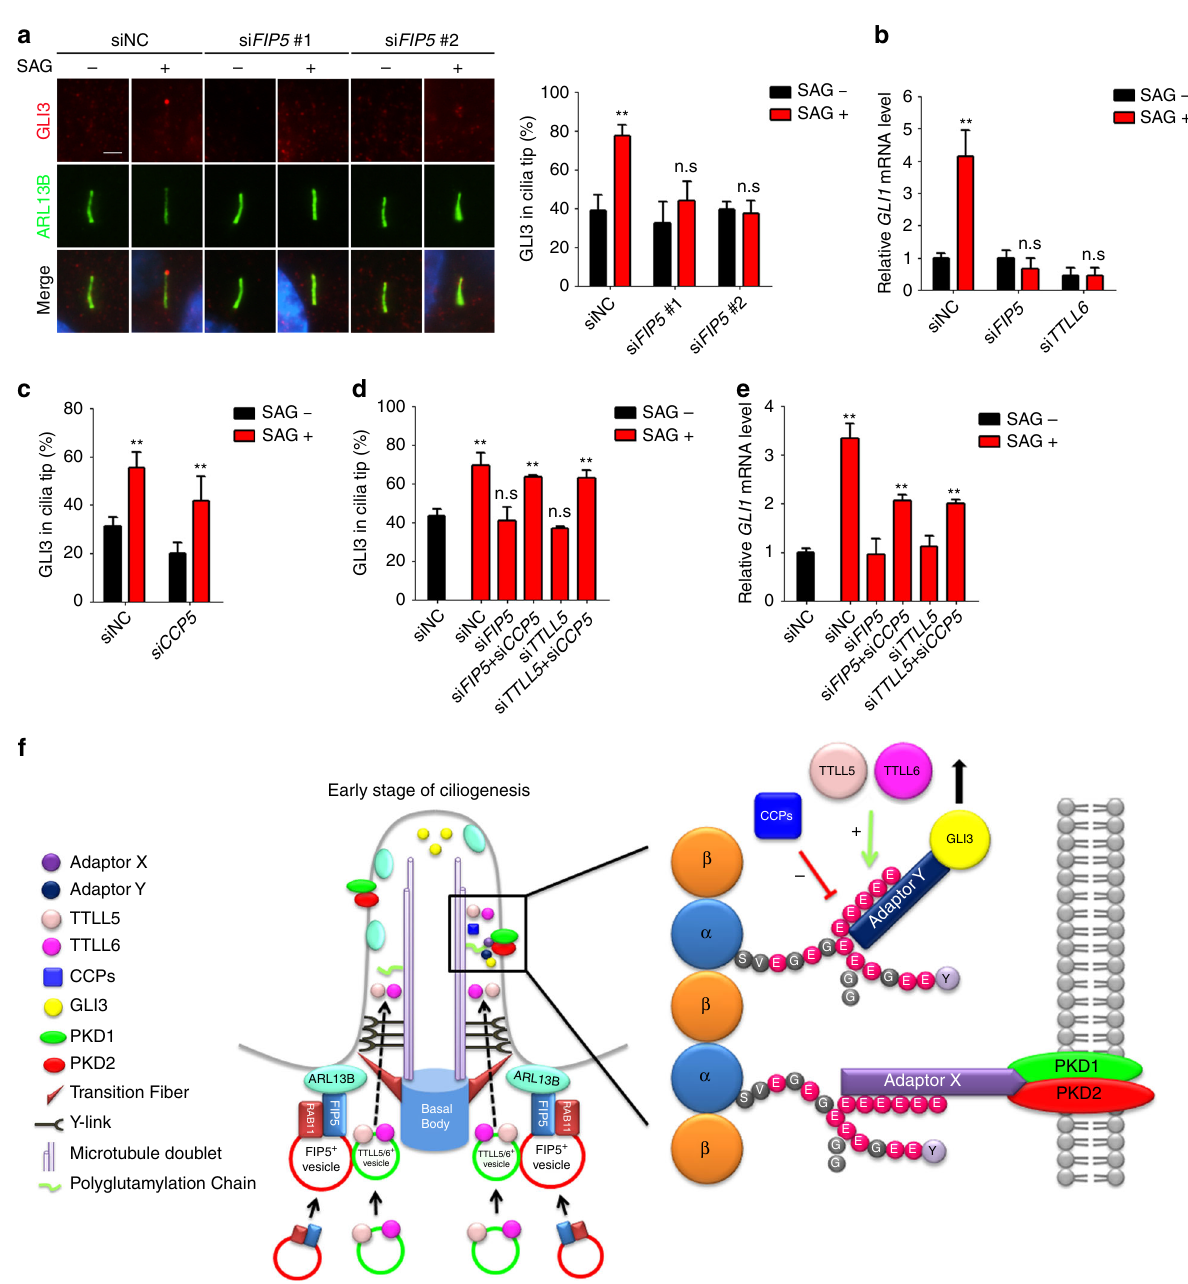
Fig. 7 Defective Shh signaling induced by axoneme hypoglutamylation can be restored by concomitant CCP5 depletion. a hTERT-RPE-1 cells were treated with the indicated siRNAs for 48 h, serum starved, and treated with 500 nM SAG for 24 h. GLI3 ciliary localizations were examined by immuno fl uorescent staining. Percentages of the cilia with GLI3 at cilia tip were quanti fi ed. Scale bar: 2 μ m. b Depletion of either FIP5 or TTLL6 abolished G LI1 expression upon hedgehog activation. hTERT-RPE-1 cells were treated with the indicated siRNAs for 48 h, serum starved, and treated with 500 nM SAG for 24 h. The relative mRNA levels of GLI1 were measured by real-time PCR. c Depletion of CCP5 suppressed GLI3 localization to cilia tip. Percentages of the cilia with GLI3 in cilia tip were quanti fi ed. d Depletion of CCP5 restored the ciliary tip localization of GLI3 in FIP5 or TTLL5 -depleted hTERT-RPE-1 cells. Percentages of the cilia with GLI3 in cilia tip were quanti fi ed. e Depletion of CCP5 rescued GLI1 expression induced by SAG as seen by real-time PCR. Data shown in a – e are the statistical analysis of three independent experiments. f Schematic model of polyglutamylation regulation and function in the context of cilia. During the early stage of ciliogenesis, ARL13B recruits RAB11/FIP5-positive vesicles, and then RAB11/FIP5-positive vesicles tether TTLL5/6-containing vesicles to the proximity of the ciliary base, which allowing cilia import of TTLL5/6. Inside cilia, axoneme polyglutamylation was controlled by the balanced enzymatic activities between TTLLs (mainly TTLL5 and TTLL6) and ciliary deglutamylase CCPs (CCP5 and other CCPs that shorten the long glutamate chains). Polyglutamylated axoneme anchors sensory receptor polycystins to the ciliary surface via unknown adaptor mechanism, which could interact with both the glutamylated chain and the intercellular domain of Polycystins. Additionally, axoneme polyglutamylation is required for proper translocation of hedgehog signaling molecule GLI3 to the ciliary tip, likely through a different adaptor mechanism that can recognize both polyglutamylated chain and intra fl agellar transport machinery. Center values represent mean. Error bars represent s.d. Statistical signi fi cance was determined using two-way ANOVA test. * p < 0.05; ** p < 0.01. n.s. not signi fi